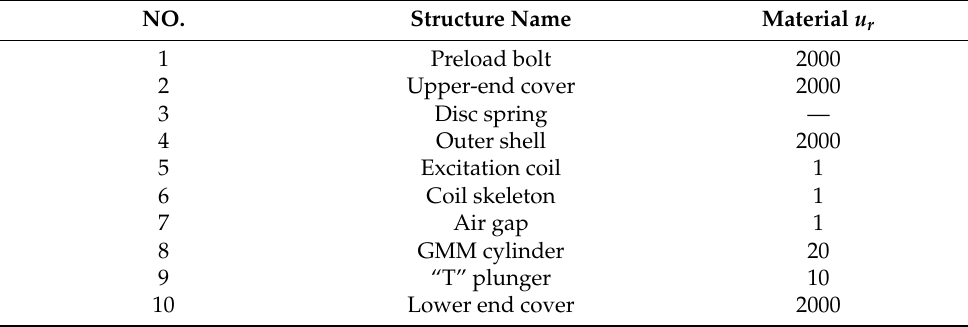
Figure 1. Schematic diagram of the structure of the GMA device. Table 1. Actuator material properties.